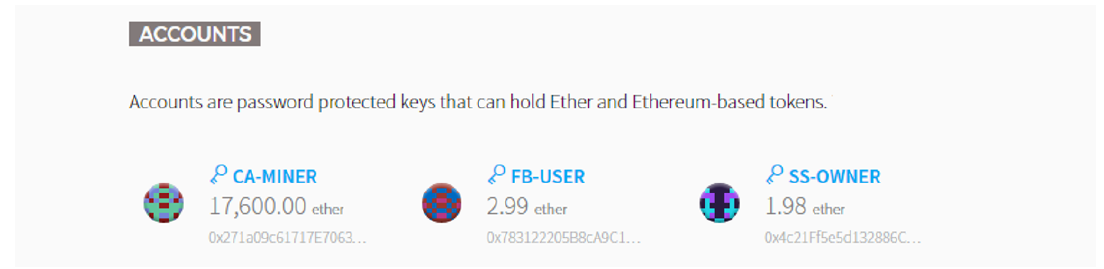
Figure 10. Results after operating the smart contract in Mist-Browser.